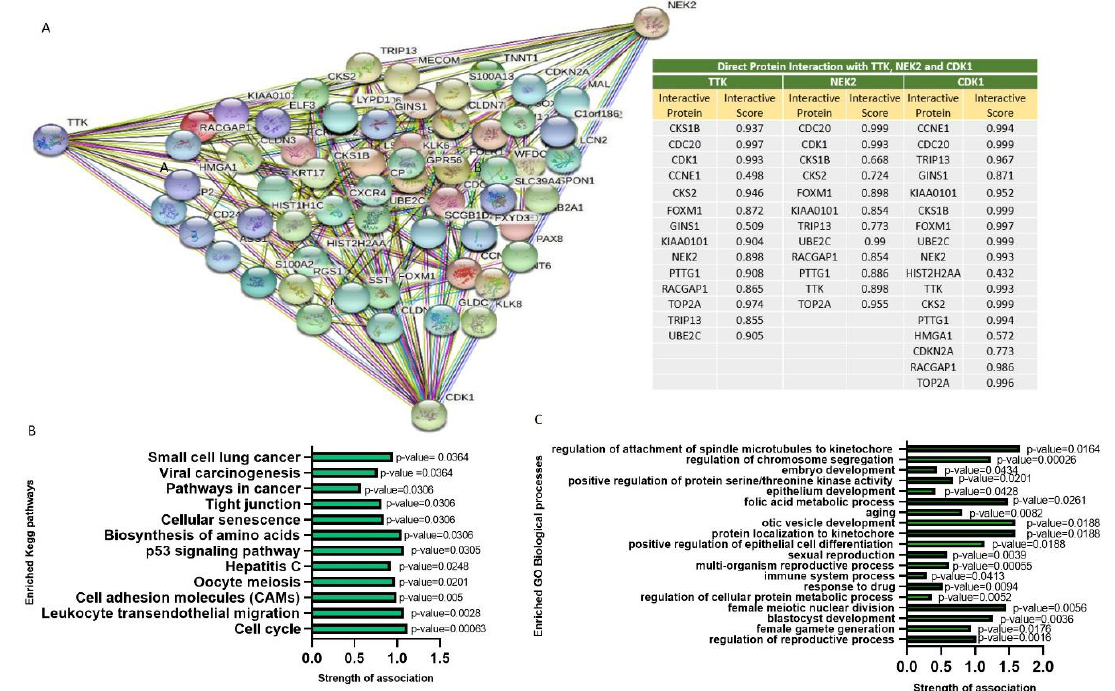
Figure 2. Protein-protein interaction (PPI) network visualization of TTK, NEK2, and CDK1. ( A ) Clustering network of TTK, NEK2, and CDK1 interactions generated 72 nodes and 166 edges with an average local clustering coefficient of 0.486 and PPI enrichment p < 10 − 16 . Accompanying table shows the proteins interacting with TTK, NEK2, and CDK1 representing the highest-scoring interacting link to 0.999 ( B ) The Kegg pathways ( C ) Biological processes associated with TTK, NEK2, and CDK1 clustering